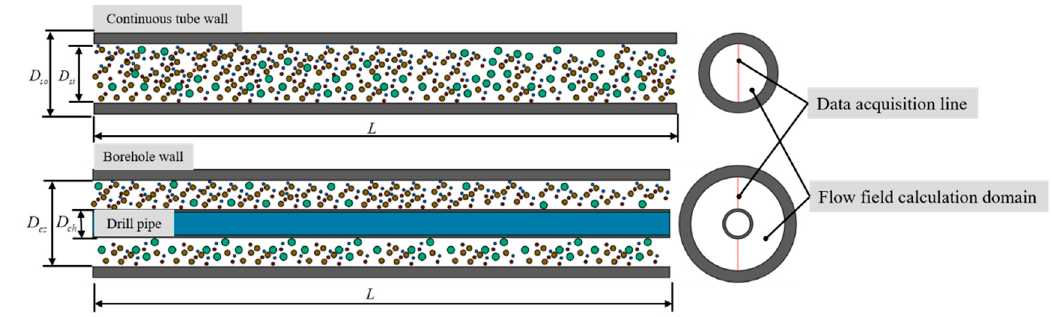
Figure 7. Schematic diagram of the numeric ‐ simulation physical model.